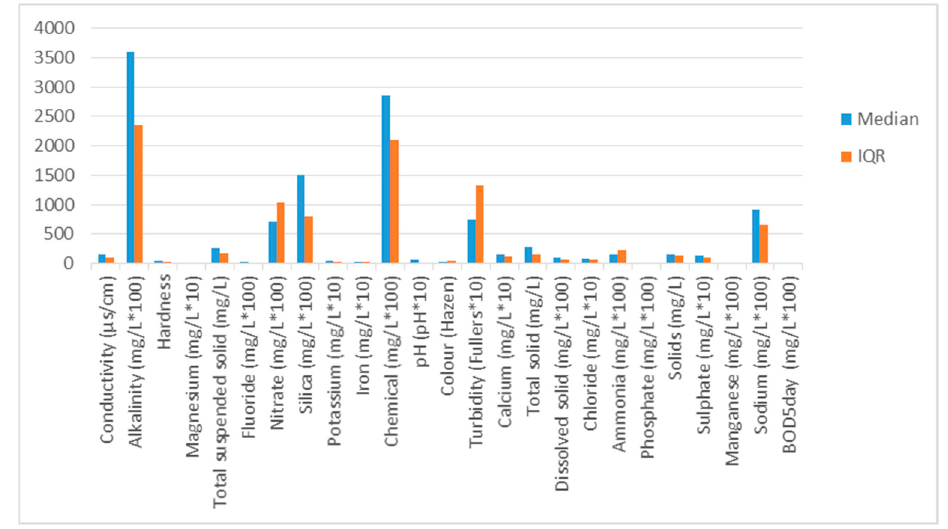
Figure 1. The statistical analysis for water quality parameters based on the raw data.